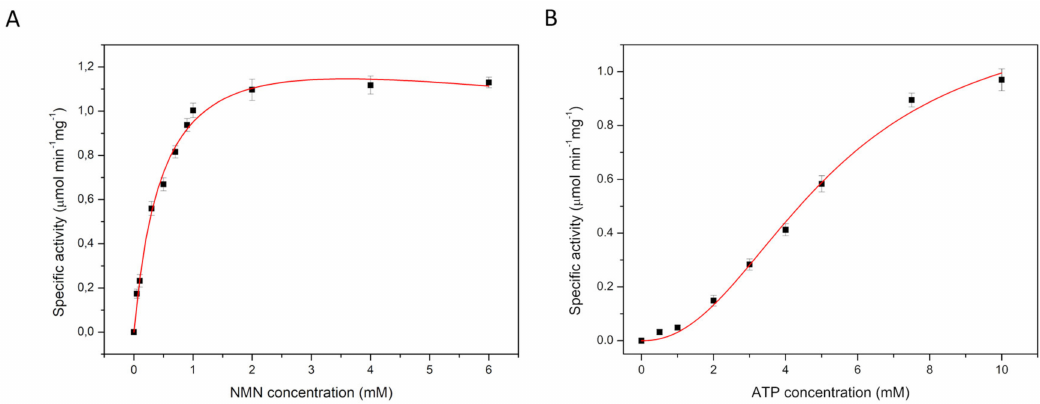
Figure 3. Apparent K m and V max determination for substrates nicotinamide mononucleotide (at a constant ATP concentration of 10 mM) ( A ) and ATP (at a constant NMN concentration of 1 mM) ( B ).